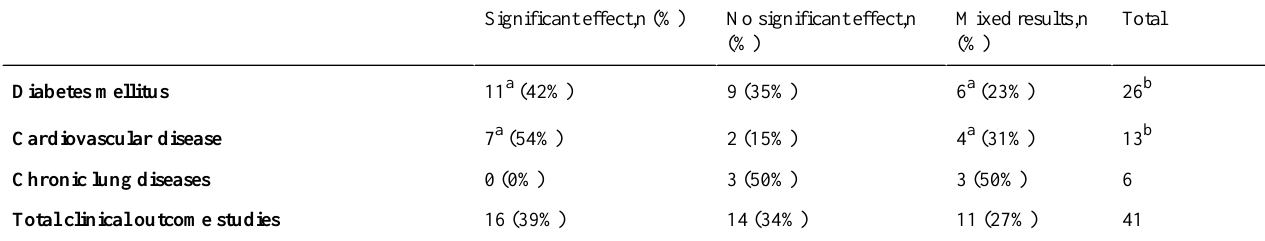
Table 3. Effectiveness of mAdherence on clinical outcomes